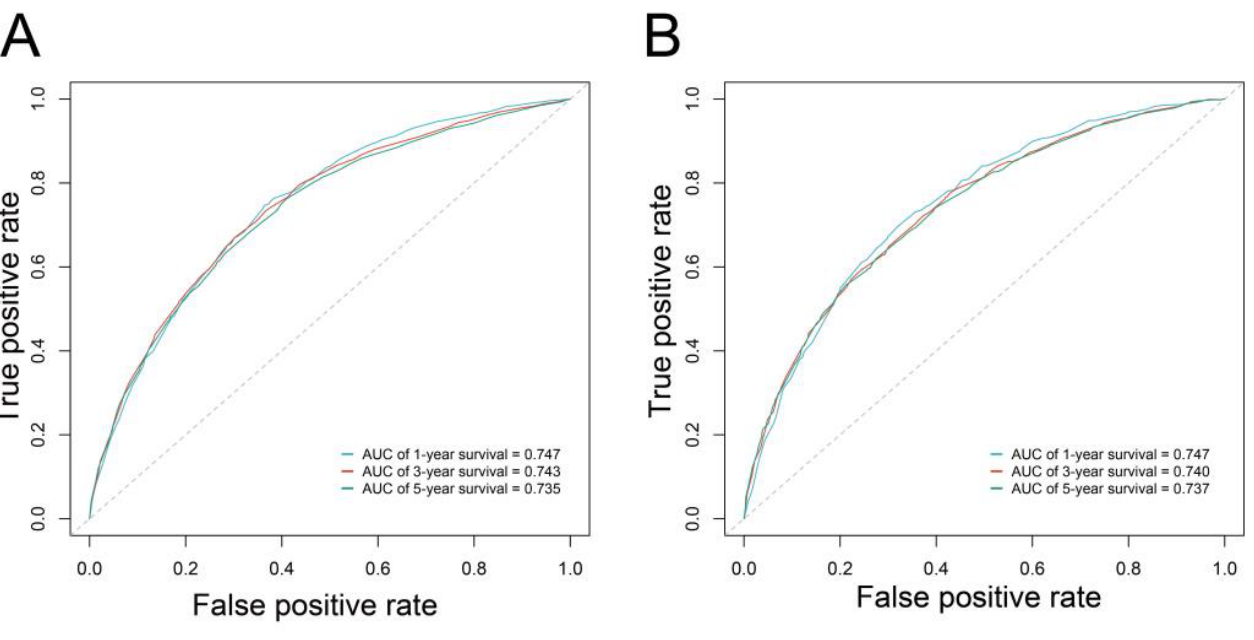
Figure 4. Receiver operating characteristic curve of the nomogram in the training ( A ) and validation ( B ) cohorts.